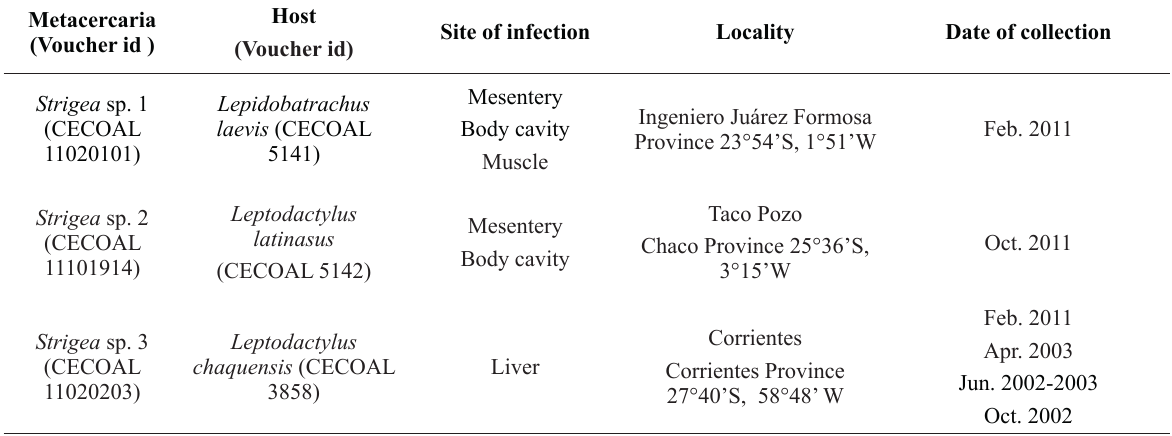
Strigeid metacercariae recorded in amphibian hosts from Argentinean Chaco region. Metacercaria (Voucher id